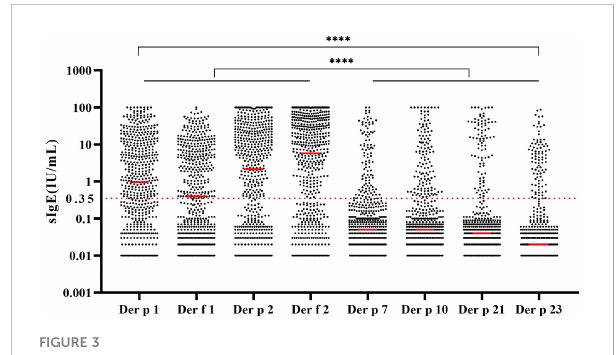
FIGURE 3 Levels and distribution of house dust mite component-speci fi c IgE in 548 samples. All the groups were compared by Kruskal – Wallis test. **** p <